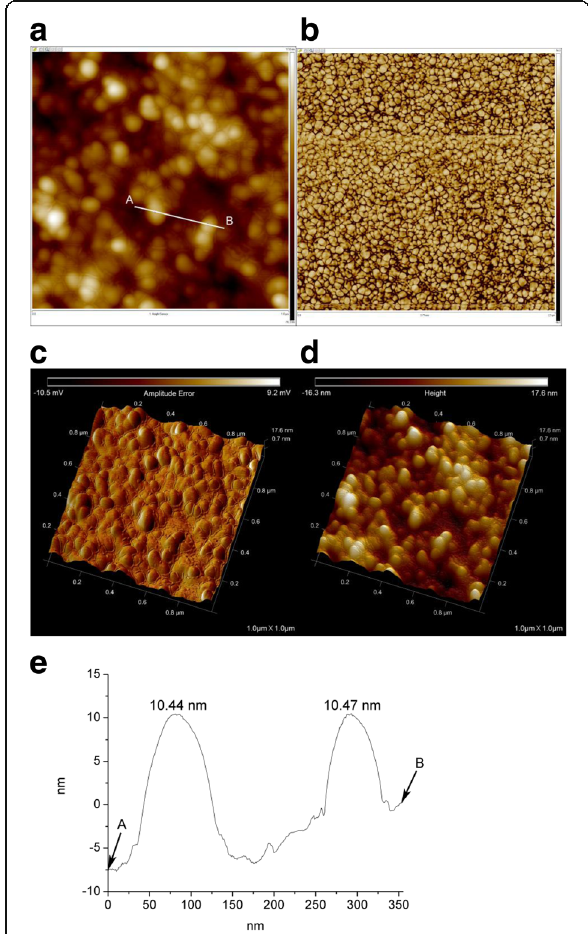
1 μ m). b 2D phase (2.5 μ m×2.5 μ m). c 3D amplitude error (1 μ m×